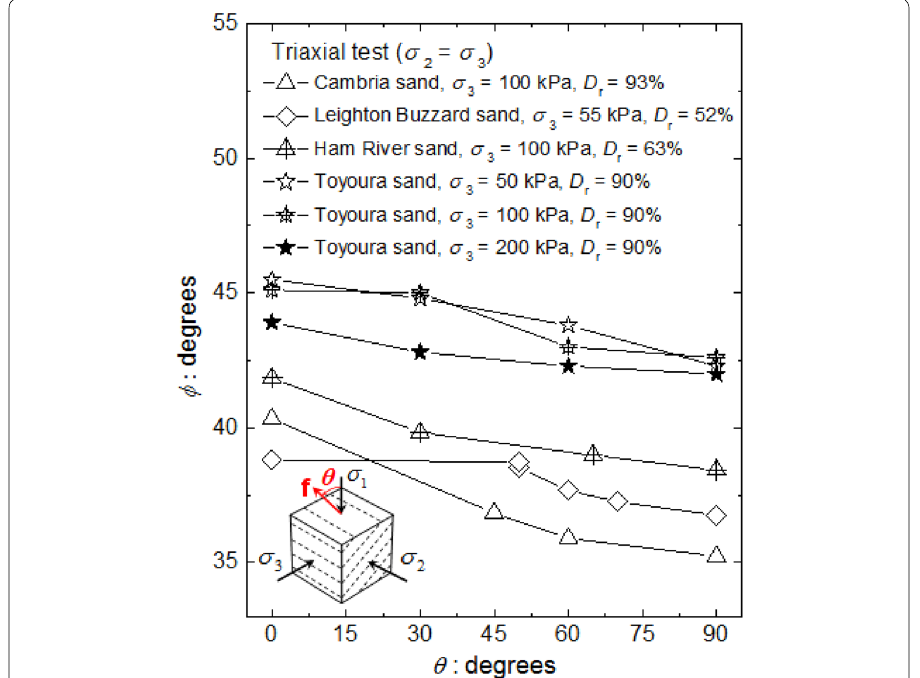
Fig. 2 Anisotropic strength of four sands in symmetrical triaxial